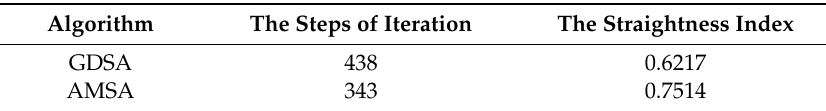
Table 2. A comparison between two algorithms.